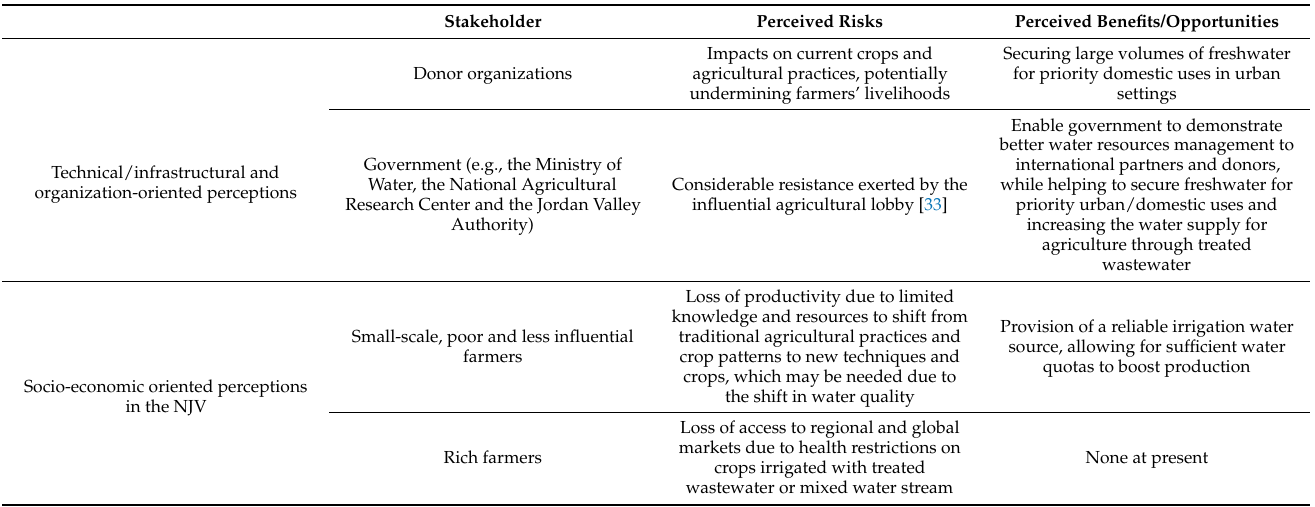
Table 6. Risks and benefits of water reuse as perceived by key stakeholders in the Northern Jordan Valley